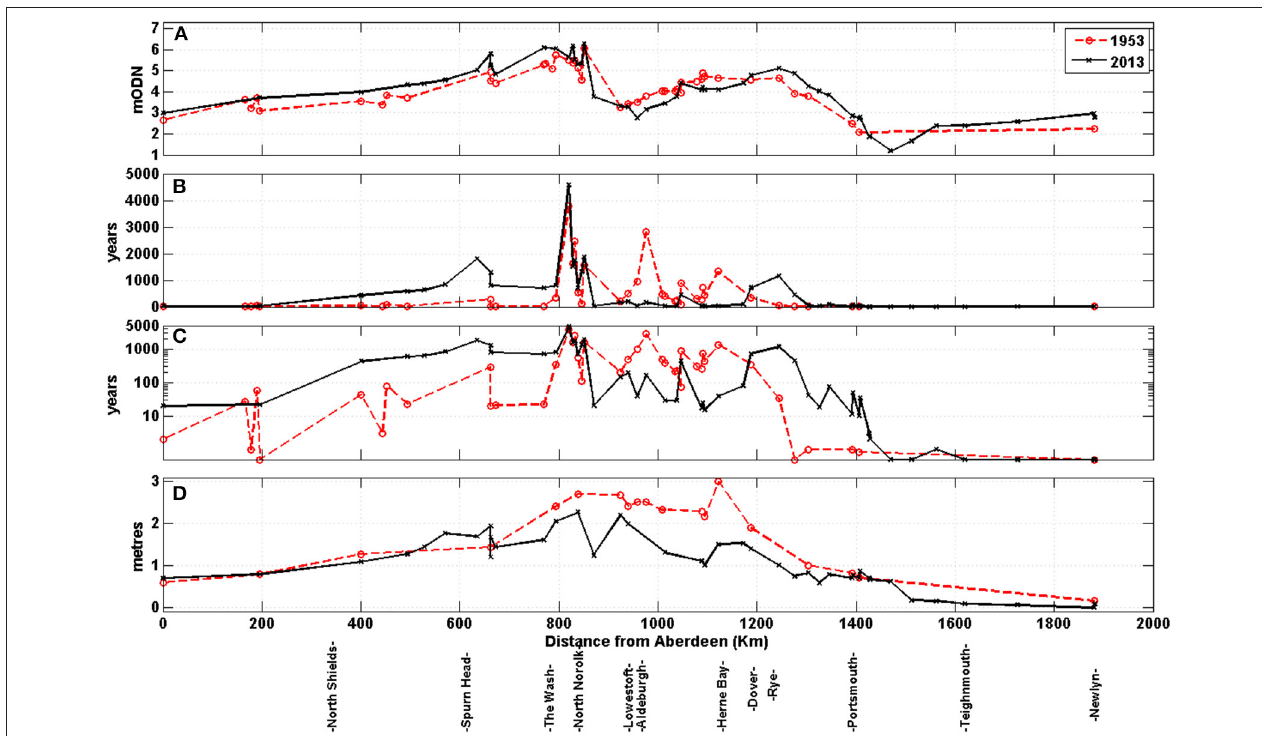
FIGURE 4 | Line plot to compare the: (A) observed high waters; (B) return periods on a non-logarithmic y-scale and (C) on a logarithmic y-scale; and (D) skew surges of the 1953 and 2013 events in the North